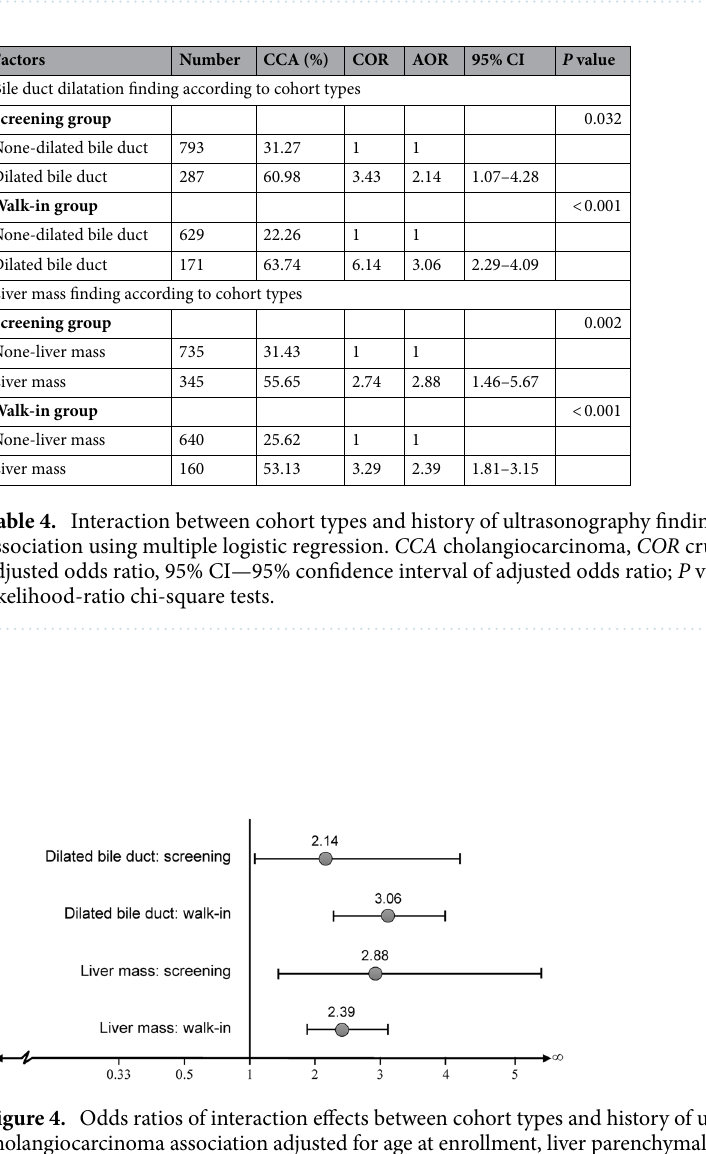
Figure 3. Odds ratios of the association between history of ultrasound findings and cholangiocarcinoma adjusted for cohort types and age of subjects at enrollment.